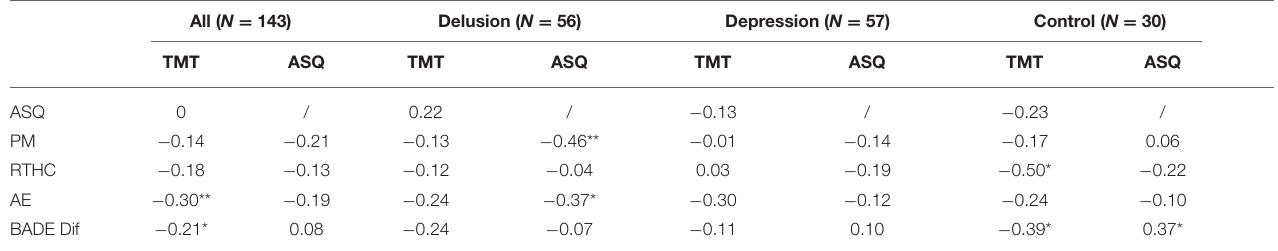
TABLE 4 | Correlations between flexibility indices within each